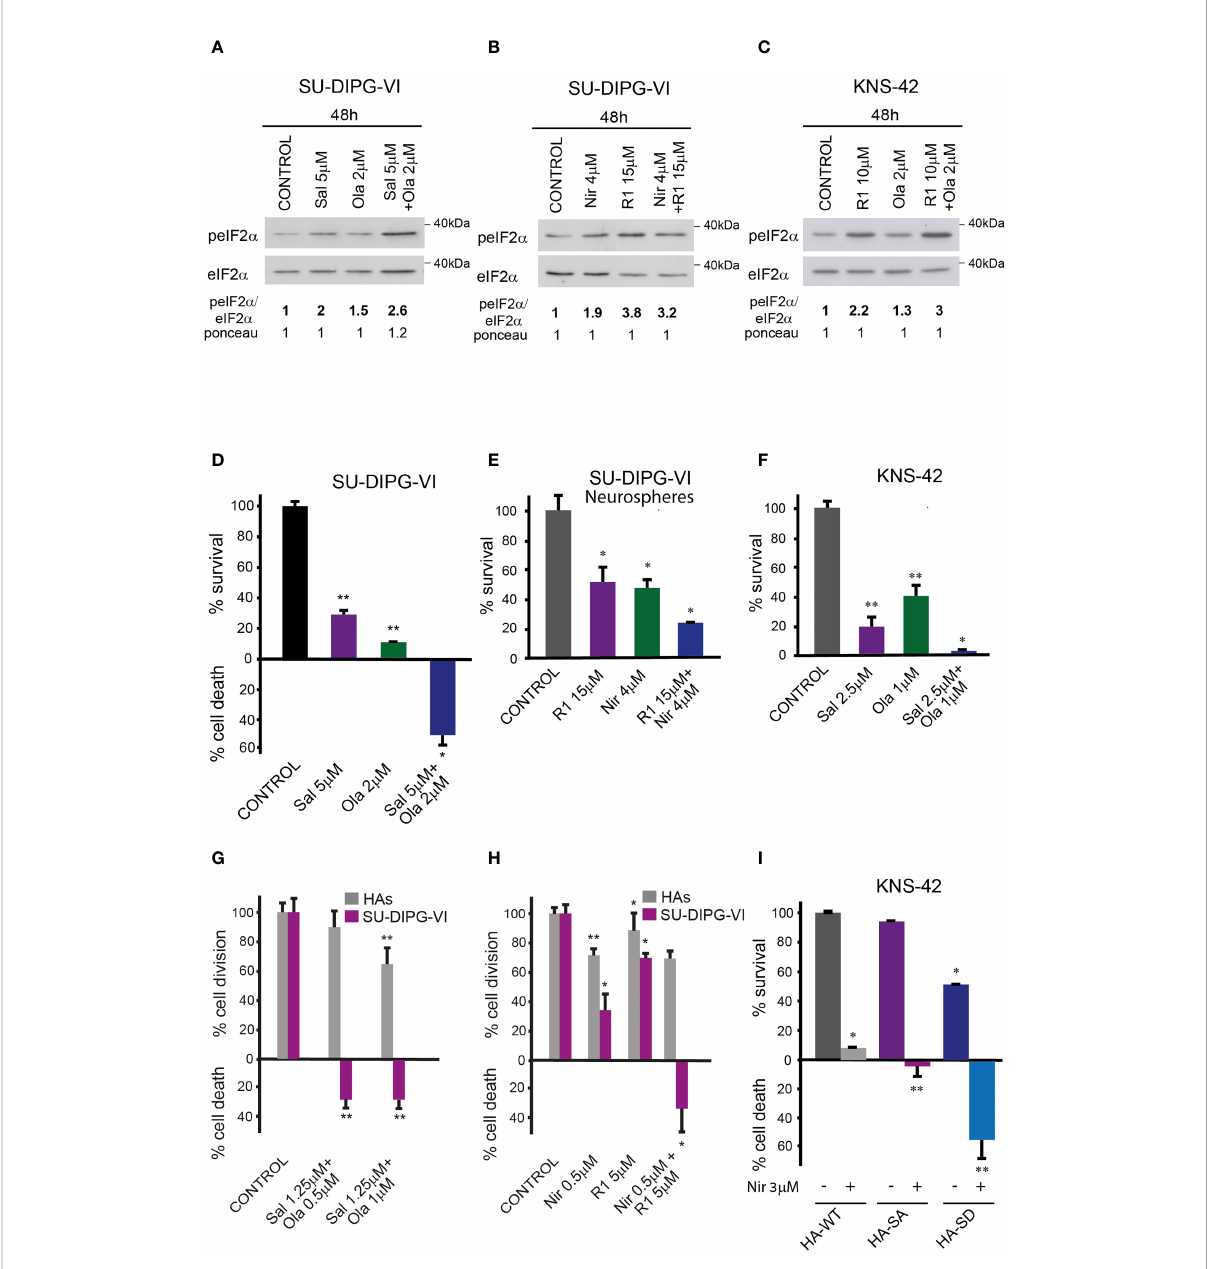
FIGURE 5 Combination of PARPis and salubrinal or raphin-1 enhanced the decrease in cell survival. (A – C) Cells were processed for Western blot analysis of treatment-induced changes in the ratio of peIF2 a /eIF2 a . Numbers at the bottom of the autoradiograms indicate changes of peIF2 a /eIF2 a and differences in loaded proteins (Ponceau) relative to control. (D, E) . SU-DIPG-VI cells were plated at a density of 11,550 cells/cm 2 , treated with drugs either 24 h (D) or 120 h (E) post-plating and incubated for additional 7 days. (F) . KNS-42 cells were plated in triplicates for clonogenic assay at a density of 55 cells/cm 2 and treated with drugs 24 h post-plating. Values are mean survival or cell death (%) ± S.D relative to control. Differences among all experimental groups, as well as between each experimental group and control, were signi fi cant — *p< 0.05, **p< 0.005 (D – F) . (G, H) . SU-DIPG VI and HAs cells were plated in triplicates at a density of 3,300 cells/cm 2 and treated with drugs 24 h post-plating. Values are mean number of cell division or cell death (%) ± S.D relative to control. Differences between treated and untreated experimental groups, as well as between SU-DIPG-VI and HAs, were signi fi cant — *p< 0.05, **p< 0.005. (I) . KNS-42 cells were plated in duplicates at a density of 13,200 cells/cm 2 and transiently transfected with 1 m g/ml of plasmids expressing HA-eIF2 a (HA-WT) or HA-S51A-eIF2 a (HA-SA), or with HA- S51D-eIF2 a (HA-SD) 24 h post-plating. Twenty-four hours later, cells were treated with niraparib for 6 days. Values are mean survival (%) ± S.D relative to control. Differences between survival of HA-SD with or without niraparib to either treated or untreated HA-SA or HA-WT were signi fi cant — *p< 0.05, **p< 0.005. Sal — salubrinal, R1 — raphin-1, Ola — olaparib, Nir — niraparib. The experiments were reproduced at least twice with similar